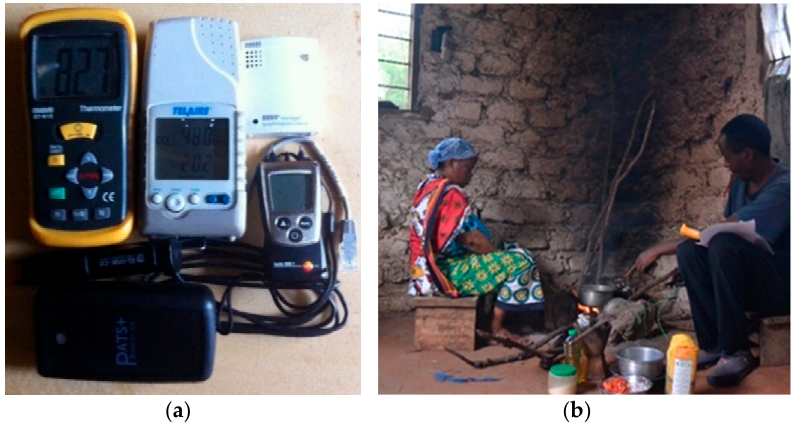
Figure 3. ( a ) Equipment used in this study; and ( b ) emission measurement during normal